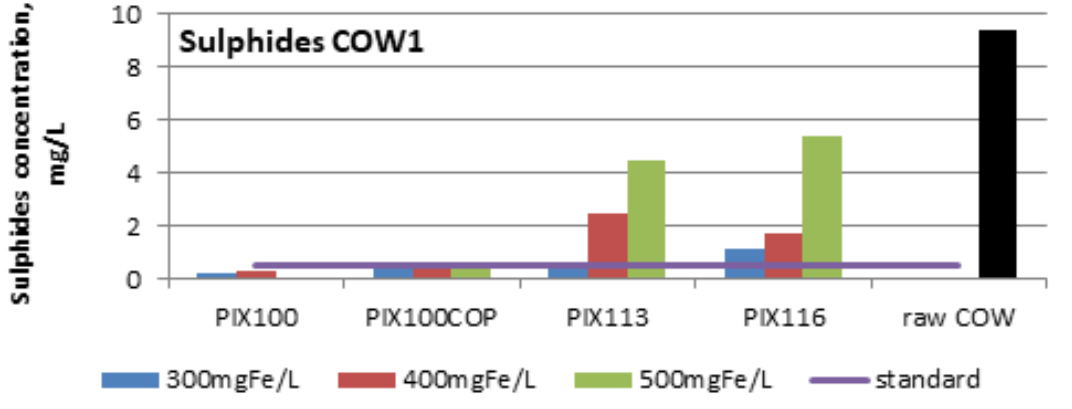
Figure 10: Final concentration of sulphides in